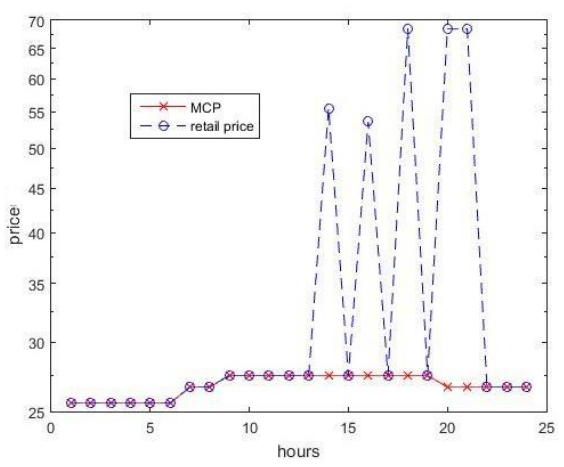
Figure 9. Customers’ demand.